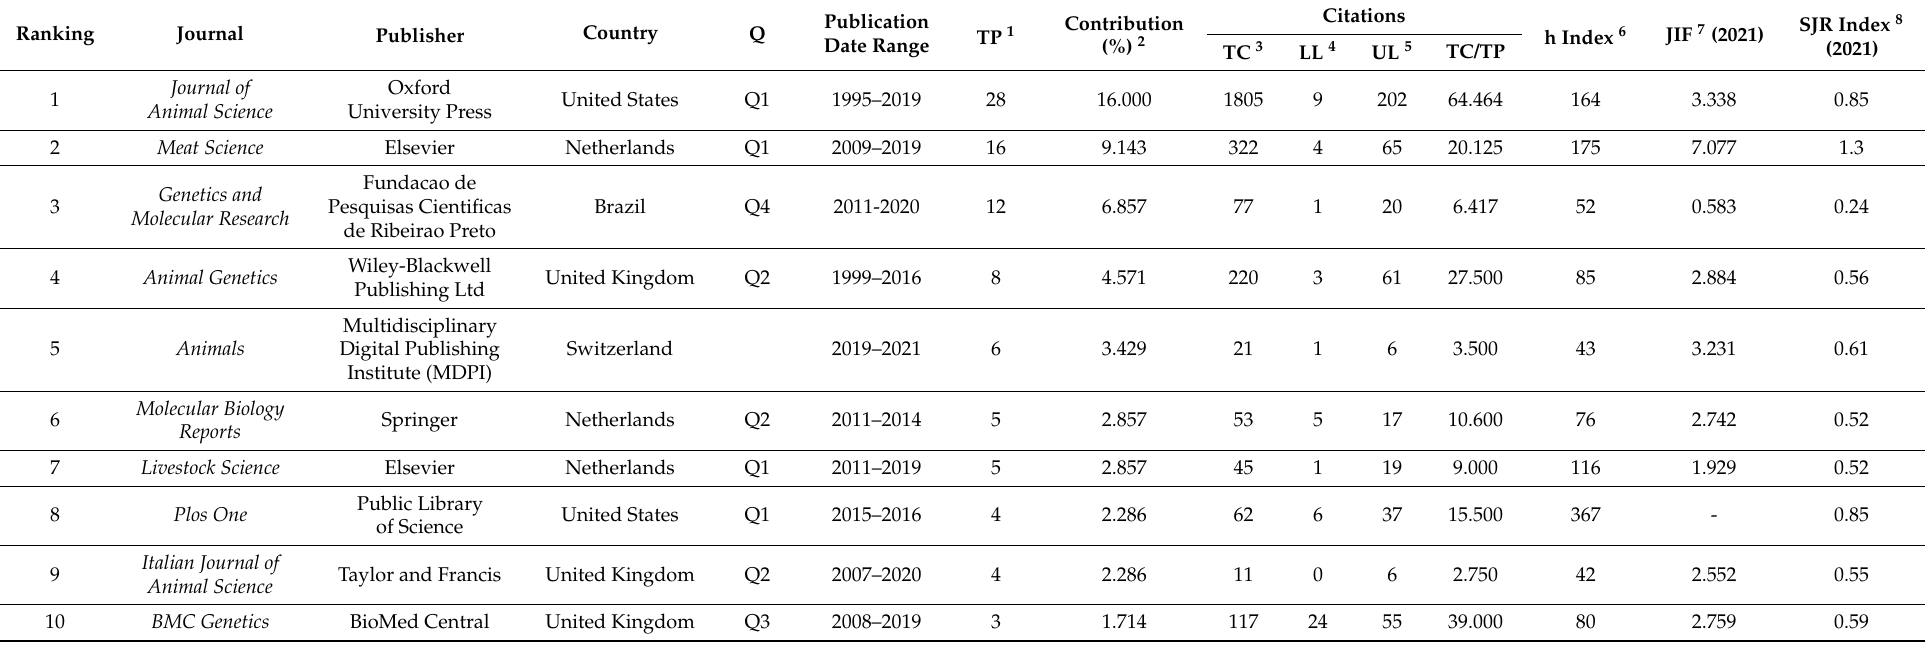
Table 4. Journals with more research on the role of causal genes in meat